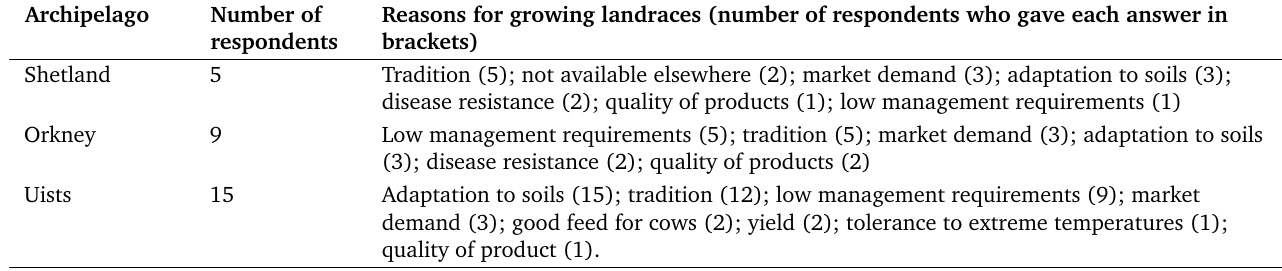
Table 4. Summary, by archipelago, of reasons for farmers growing